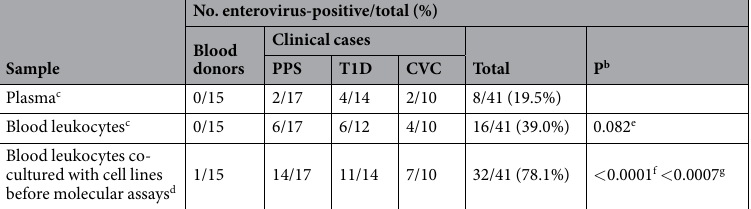
Table 4. Comparison of virus positivity rates in plasma and in blood leukocytes versus blood leukocytes that had been co-cultured with cell lines before molecular assays a . a EV-specific RT-PCR assays performed with primer pairs 5 ′ UTR-A, -B, -C, -D as in the Methods section. Positivity assigned to visible bands of the expected size in agarose gels. b Fisher’s exact test, two-sided. c Plasma and blood leukocytes: direct RNA extraction, then RT-PCR. d Blood leukocytes co-cultured with cell lines for 3–6 passages. RNA was extracted from cell culture medium, then RT-PCR. e P value: blood leukocytes vs. plasma. f P value: co-culture method vs. plasma. g P value: co-culture method vs. blood leukocytes.